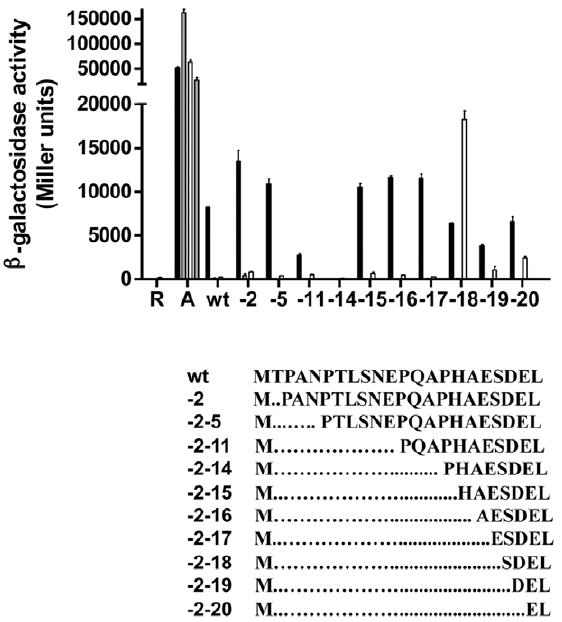
Figure 3. Influence of N-terminal truncations on the ability of NifL to regulate transcriptional activation by NifA. The number of residues missing from the N-terminus (including the initial methionine) is indicated numerically on the x axis and the sequence of each truncation is represented below. ‘‘R’’ indicates a control in which only the reporter plasmid was present. In all other cases, nifA was present on the plasmid together with nifL or its variants. ‘‘A’’ indicates the plasmid encodes an in-frame deletion, containing 65 C-terminal residues of NifL (pPR39). This plasmid acts as a control for NifA activity in the absence of active NifL [14]. ‘‘wt’’ indicates native NifL. Cultures were assayed for b -galactosidase activity as a reporter of NifA-mediated transcriptional activation from the nifH p -lacZ fusion on plasmid pRT22 as described previously [12]. Cultures were grown under the following conditions; anaerobically under nitrogen limitation with casein hydro- lysate as the sole nitrogen source (black bars), anaerobically with (NH 4 ) 2 SO 4 as nitrogen source (grey bars), and aerobically with casein hydrolysate as sole nitrogen source (white bars). (Assays were also performed on cultures grown anaerobically in the presence of (NH 4 ) 2 SO 4 , but b -galactosidase activities were too low to display on this scale.) All experiments were performed at least in duplicate with error bars denoting the standard error of the mean.